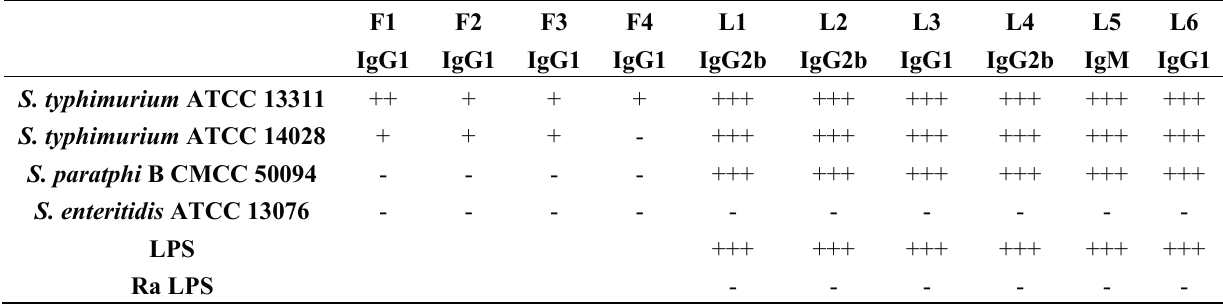
Table 1. Isotype and cross-activity of S. typhimurium flagellin MAbs and LPS